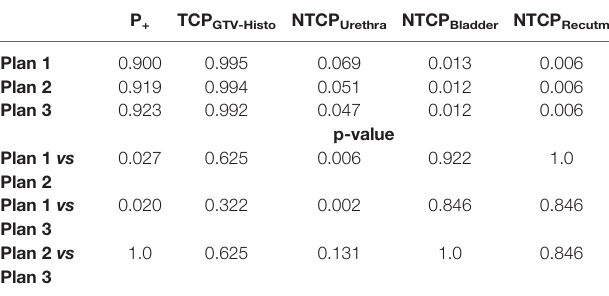
TABLE 5 | Median P + , TCP- and NTCP-values for plans 1-3, as well as p-values for comparison of plan 1 vs 2 and 3, respectively, considering intrafractional movement with a / b 1.6 Gy for tumor tissue and 3 Gy for bladder and